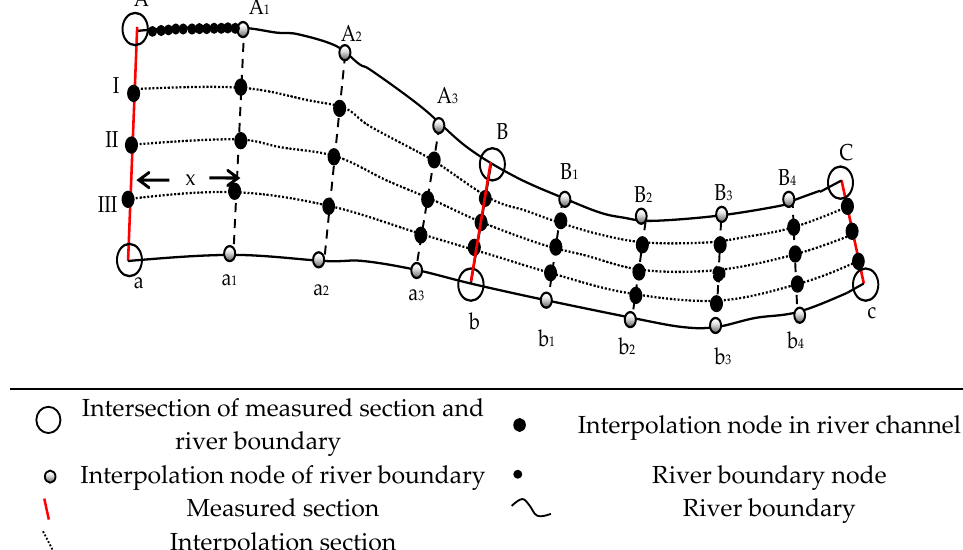
Figure 2. Schematic diagram of spatial elements of the river channel.